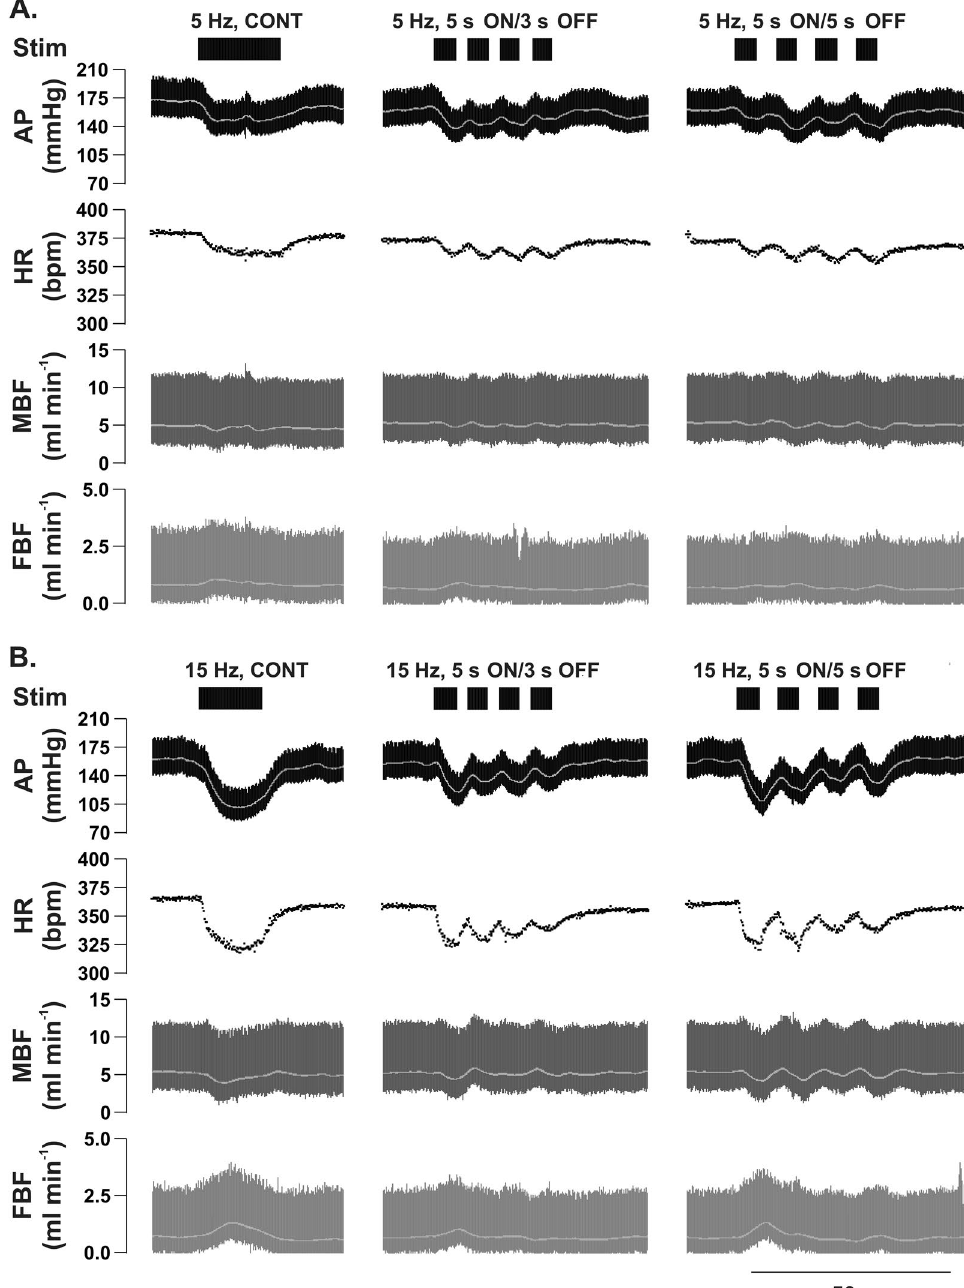
Figure 2. Representative raw data traces showing the effect of low (5 Hz, A ) and high (15 Hz, B ) frequency continuous (CONT) versus intermittent (5 s ON/3 s OFF and 5 s ON/5 s OFF) aortic depressor nerve (ADN) stimulation (0.4 mA, 0.2 ms for 20 s) on cardiovascular parameters in pentobarbital-anesthetized spontaneously hypertensive rats. Arterial pressure (AP), heart rate (HR), mesenteric blood flow (MBF) and femoral blood flow